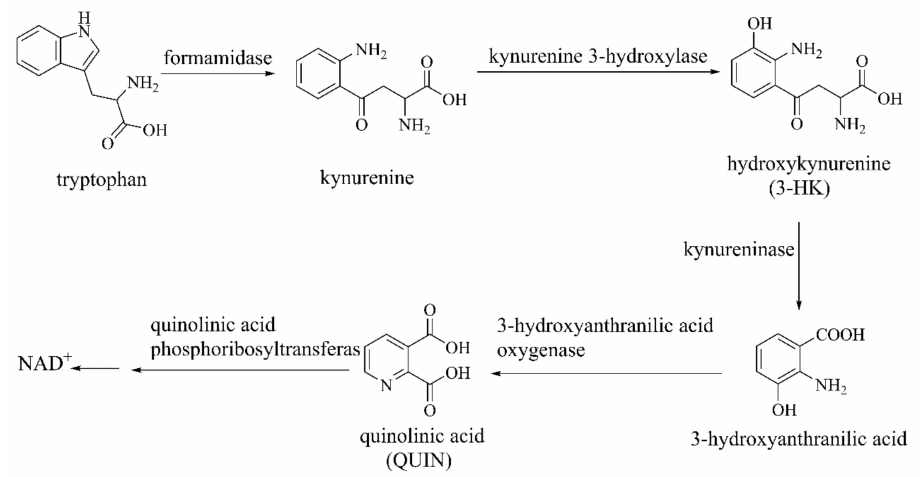
Figure 15. The biosynthesis of 3-HK, QUIN during kynurenine pathway